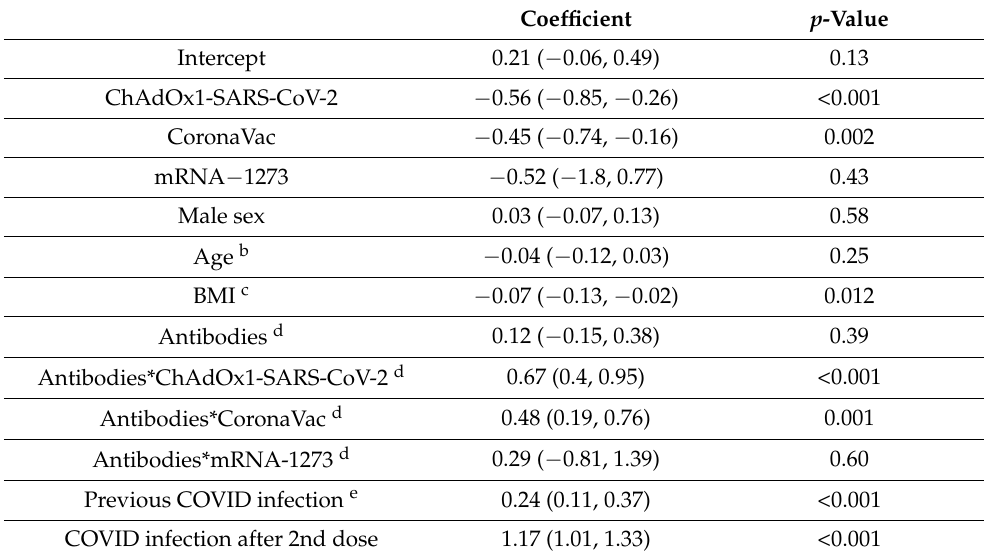
Table 3. Ordinary least square model for the antibody titers at 6-month follow-up a